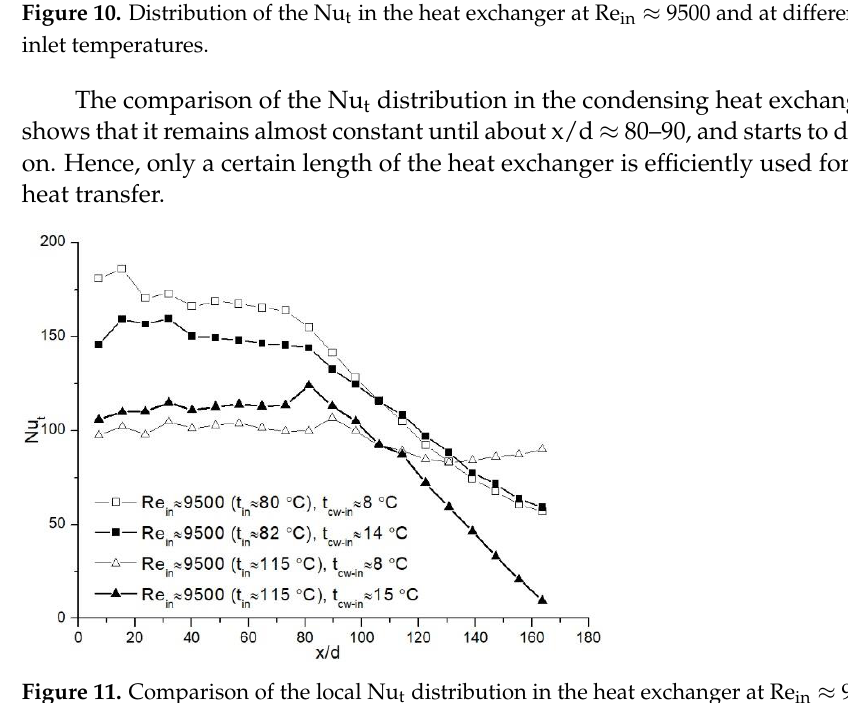
Figure 11. Comparison of the local Nu t distribution in the heat exchanger at Re in ≈ 9500, at different flue gas inlet and cooling water temperatures.